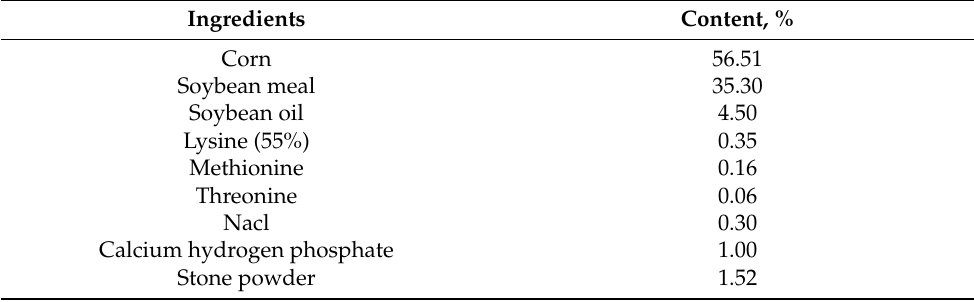
Table 1. Composition and nutrient level of the basal